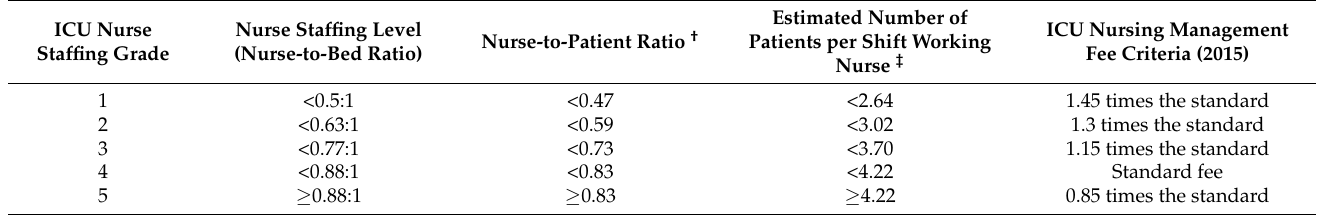
Table 1. Nurse staffing levels and ICU nursing management fee criteria according to the nursing staffing grade of the adult ICU in tertiary